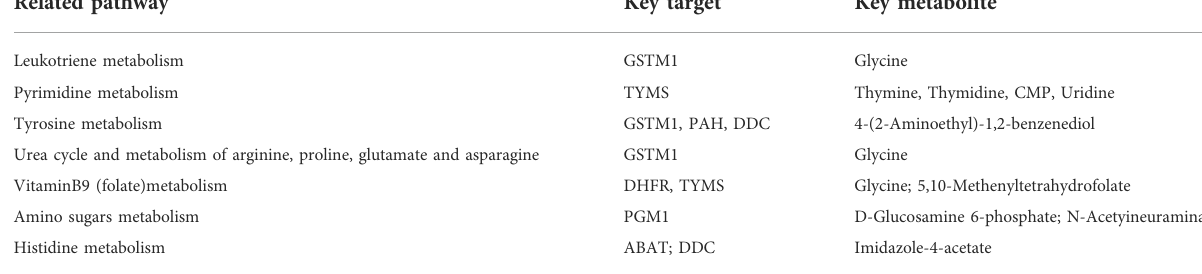
TABLE 2 The information of key targets, metabolites and pathways. Related